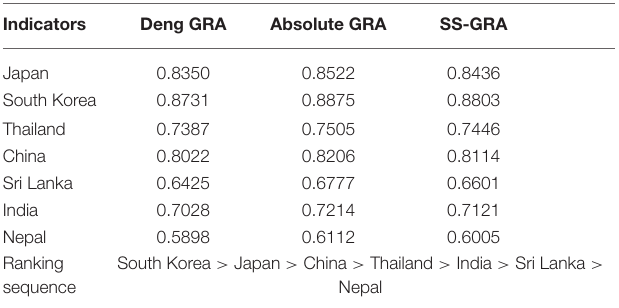
TABLE 3 | Grey assessment between IHD mortality and exposure to ground-level ozone (O 3 ).